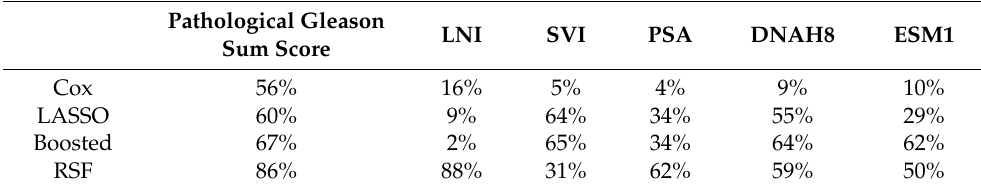
Figure 4. ( A ) Stability indices of the clinical-only models. ( B ) Stability indices of the top mRNA- inclusive pipelines. ( C ) Feature selection rates in clinical-only models (a darker shade indicates a higher rate). ( D ) Feature selection rates in the best-performing mRNA-inclusive pipelines, for features with a selection rate ≥ 0.2 in at least one of these top pipelines. For comparative purposes, the shade of grey used for ESM1 in RSF corresponds to a 50% selection rate. Table 4. Selection rates of all variables with a selection rate ≥ 50% in at least one of the best-performing mRNA-inclusive